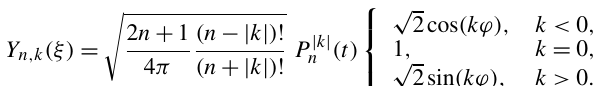
with the 50th worst 1630